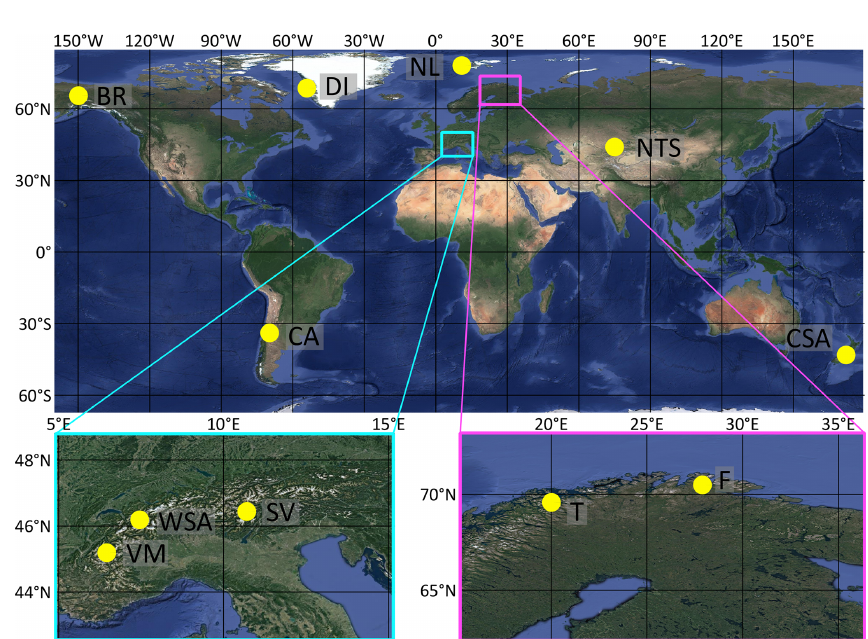
Figure 1. Location of the 11 investigated regions (yellow dots): Nordenskiöld Land (NL), Disko Island (DI), Brooks Range (BR), northern Tien Shan (NTS), Central Andes (CA) and central Southern Alps (CSA). The western Swiss Alps (WSA), southern Venosta (SV), Vanoise Massif (VM), Troms (T) and Finnmark (F) are visible in two enlarged panels. Orthoimages from © Google Earth